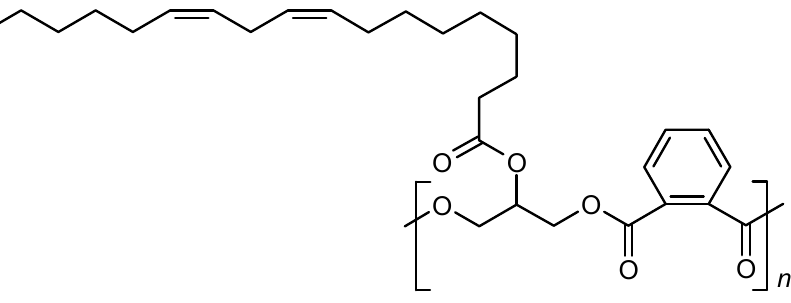
Figure 1. Structure of a typical alkyd resin with linoleic acid as side group.